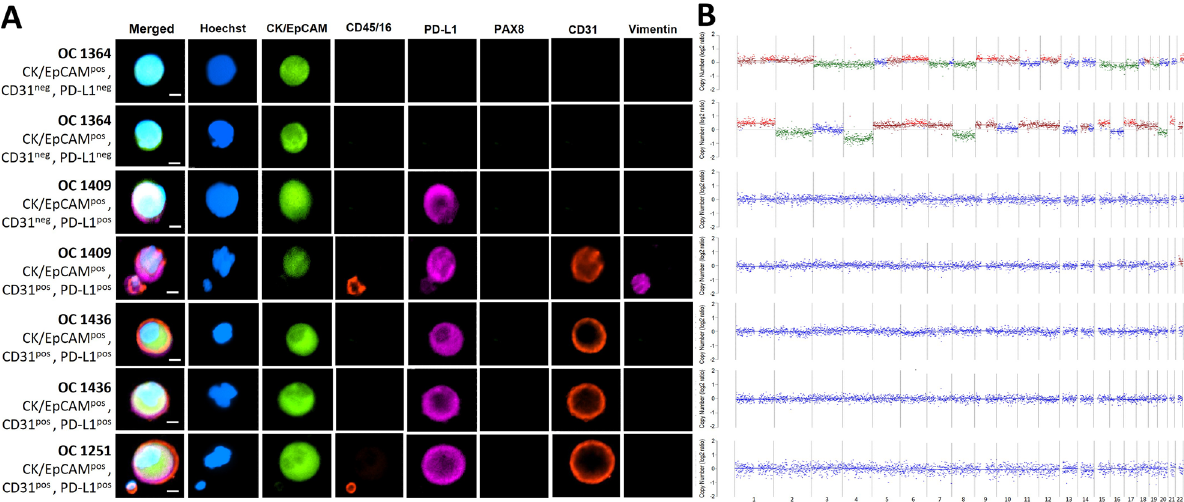
Figure 1. Representative fluorescence images of CTCs and their corresponding CNV profiles. Scale bar (bottom right) represents 10 μm. ( A ) Cells were stained with antibodies for cytokeratin and EpCAM (FITC, green), CD45/CD16 (PE, red), PD-L1 (AF647, cyan) and nuclei staining in blue (Hoechst), in the first panel. It was followed by fluorescence quenching and re-staining with antibodies for PAX8 (FITC, green), CD31 (PE, red) and vimentin (AF647, cyan) 18 . ( B ) CNA profiles obtained from low-pass whole-genome sequencing are shown to the right. Blue dots indicate neutral CNA, red indicate gains, and green indicate losses.